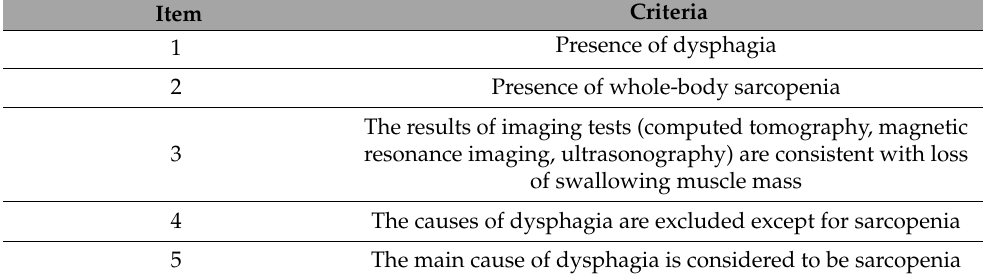
Table 1. Diagnostic criteria for sarcopenic dysphagia. Item Criteria